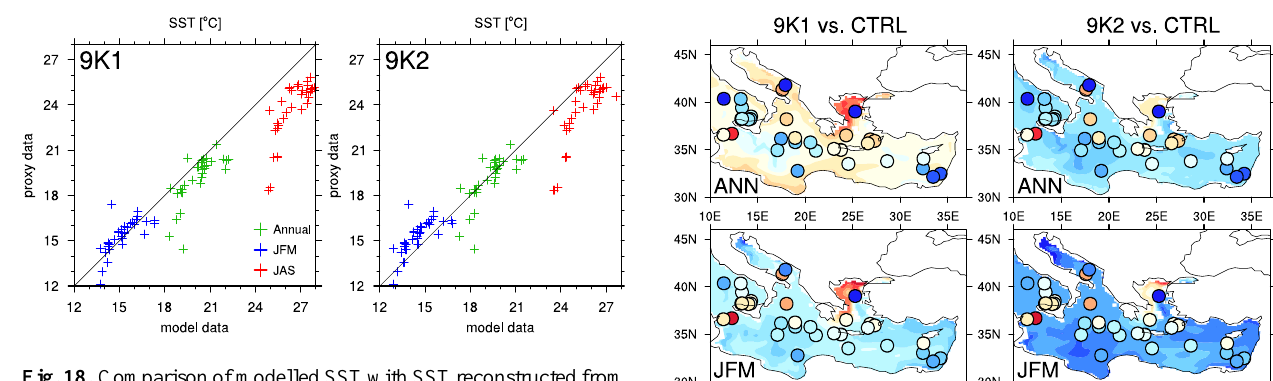
Fig. 18. Comparison of modelled SST with SST reconstructed from proxy data (Kucera et al., 2011) for 9K1 (left) and 9K2 (right). An- nual mean, winter (JFM) and summer (JAS) are considered.